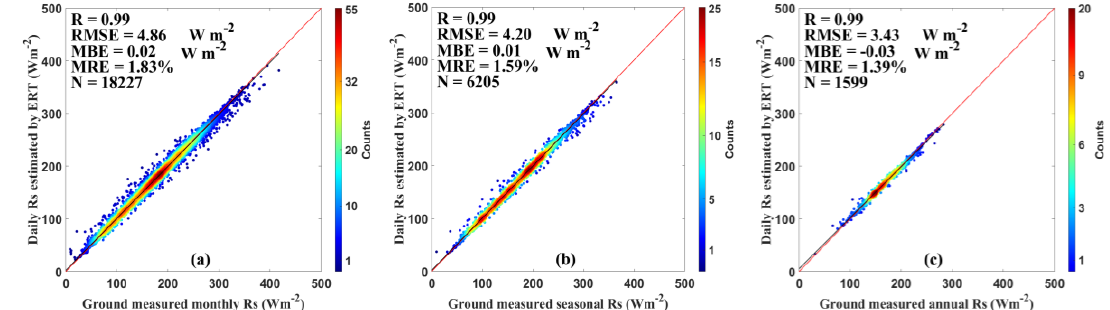
Figure 7. Evaluation results of the ERT-based model on the ( a ) monthly, ( b ) seasonal, and ( c ) annual timescales over China during 2000–2015.